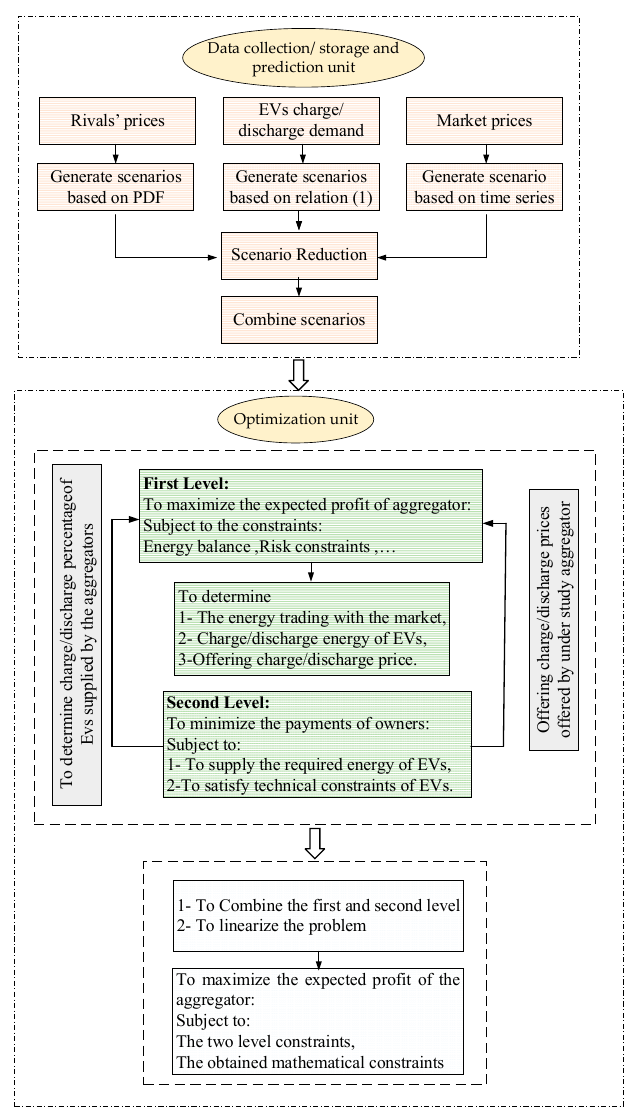
Figure 2. Flowchart of the solution methodology.